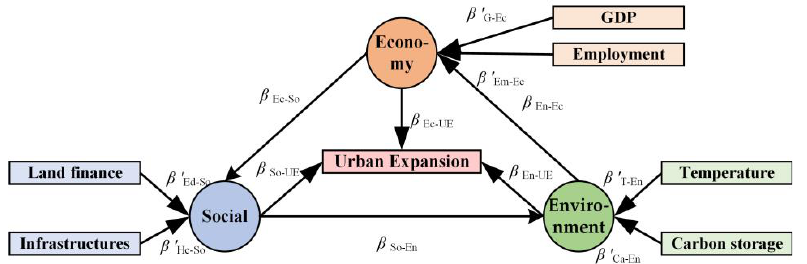
Figure 11. An example of assumed driving mechanism pending to be tested by structural equation modelling (SEM). Latent variables and observed variables are marked in circles and squares, respec- tively. Path coefficients (i.e., β , β ’ ) describe the directed prediction relationship between variables. The difference-in-differences (DID) model is a quasi-experimental approach used to study the influence of a treatment (i.e., explanatory variable) by comparing the changes in outcomes (i.e., explained variable) between a control group and treatment group over time. Therefore, DID is established to measure the impact of only a single factor (one treat- ment). For example, in DAUE study, Zhou et al. [48] applied DID to explore the impact of the administrative hierarchy system on urban expansion in China, while Deng et al. [49]